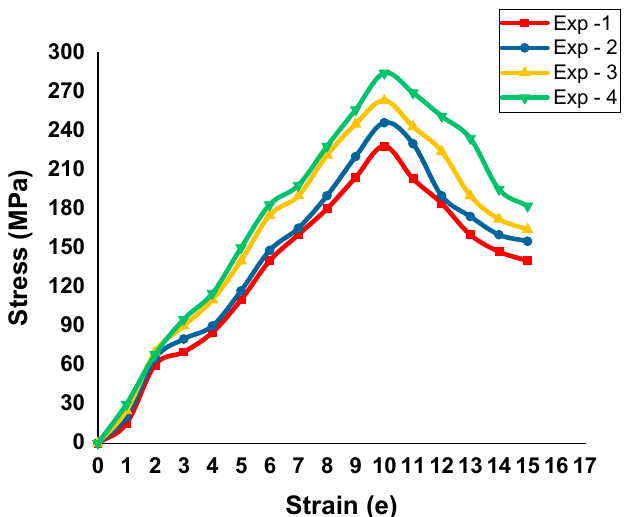
Figure 6. Stress strain curves of the different specimens